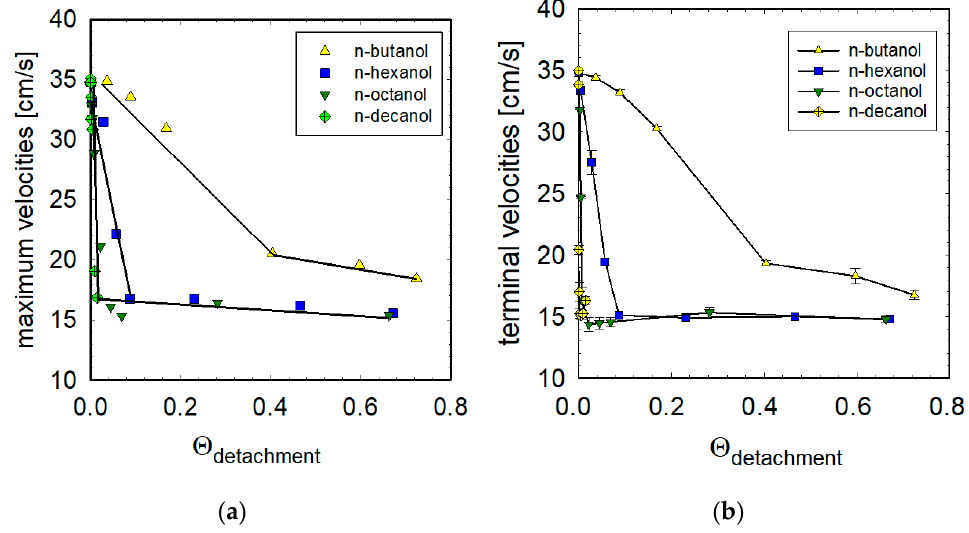
Figure 9. Maximum ( a ) and terminal ( b ) velocities as a function of the adsorption coverage upon